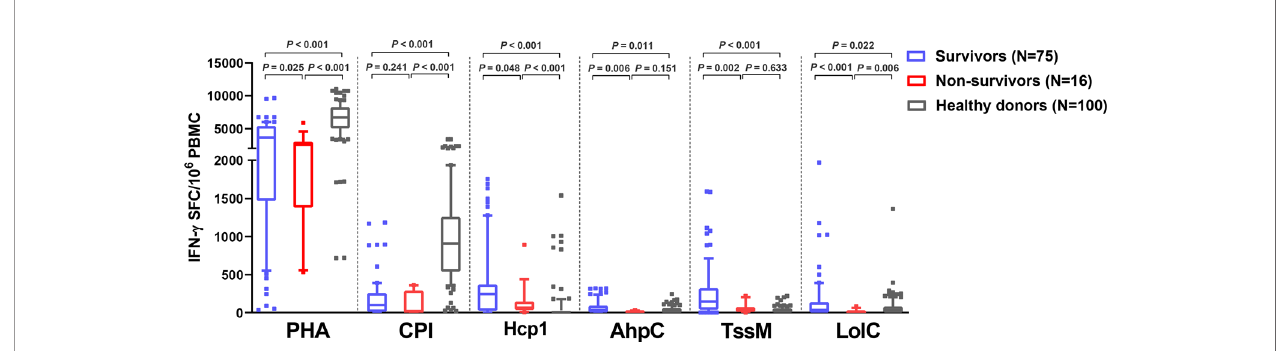
FIGURE 3 | Cellular immune responses to B pseudomallei vaccine candidate antigens in melioidosis patients during acute infection in survivors and non-survivors. IFN- g ELISpot assays were performed with cryopreserved PBMC from 100 healthy donors, 75 survivors and 16 non-survivors. Data displayed for each antigen is the number of spot forming cells (SFC) per 10 6 PBMC. Box plots represent 25 th and 75 th percentile boundaries in the box with the median line within the box; the whiskers indicate the 10 th and 90 th percentiles. Statistical signi fi cance between groups was determined using the